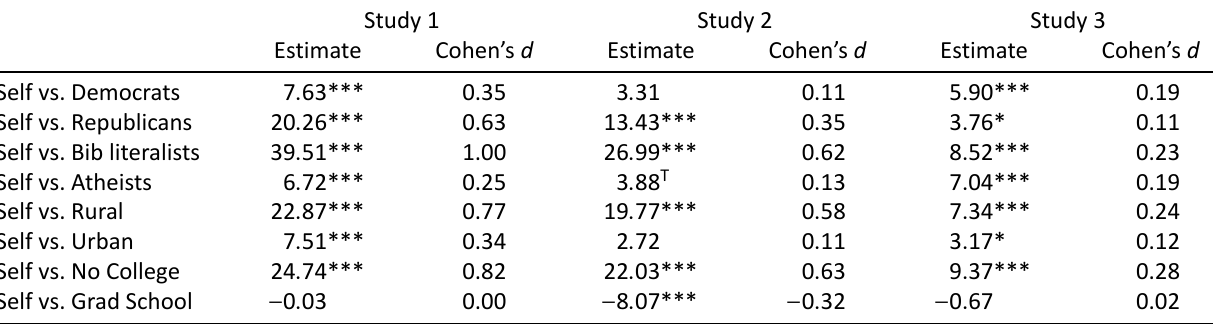
Table 1. Planned comparisons between ‘self’ and ‘other’ identity groups for how convincing each will find the flat Earth video across the three studies.